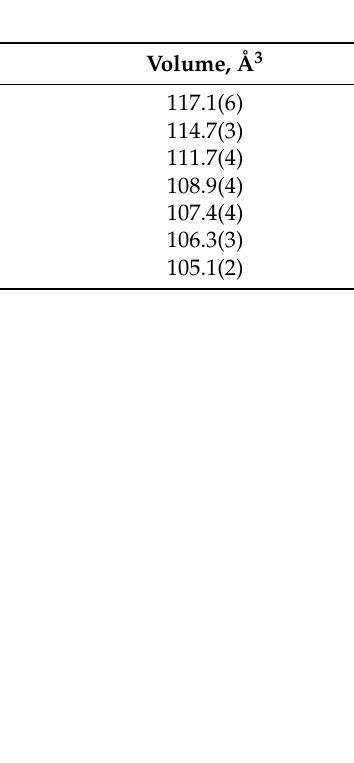
Figure 6. Calculated bulk sound velocity as a function of pressure for Ni 3 C (this study, black solid line with circles); Fe 3 C (green line with diamonds[33]) and Fe 7 C 3 (blue line with squares [2]); Ni (red line with triangles [21]); Fe (purple line with pentagons [35]) at 293 K. Thereby, the presence of Ni in the alloy likely should not affect the elastic properties of the Fe-Ni-C system at high pressure but potentially can change the carbon distribution. Due to the stability of Ni 3 C at conditions of Earth’s outer core, it may be considered as one of the likely candidates to carbon-bearing phases in the core along with Fe 7 C 3 . 4. Conclusions In the presented work, we have synthesized a nickel carbide yet unknown at ambient conditions. It was shown that Ni reacts with carbon at high-pressure and high- temperature conditions that result in the formation of an orthorhombic Ni3C compound (space group Pnma, a = 4.520(3) Å, b = 5.8014(17) Å, c = 4.009(4) Å at 84(5) GPa) with the